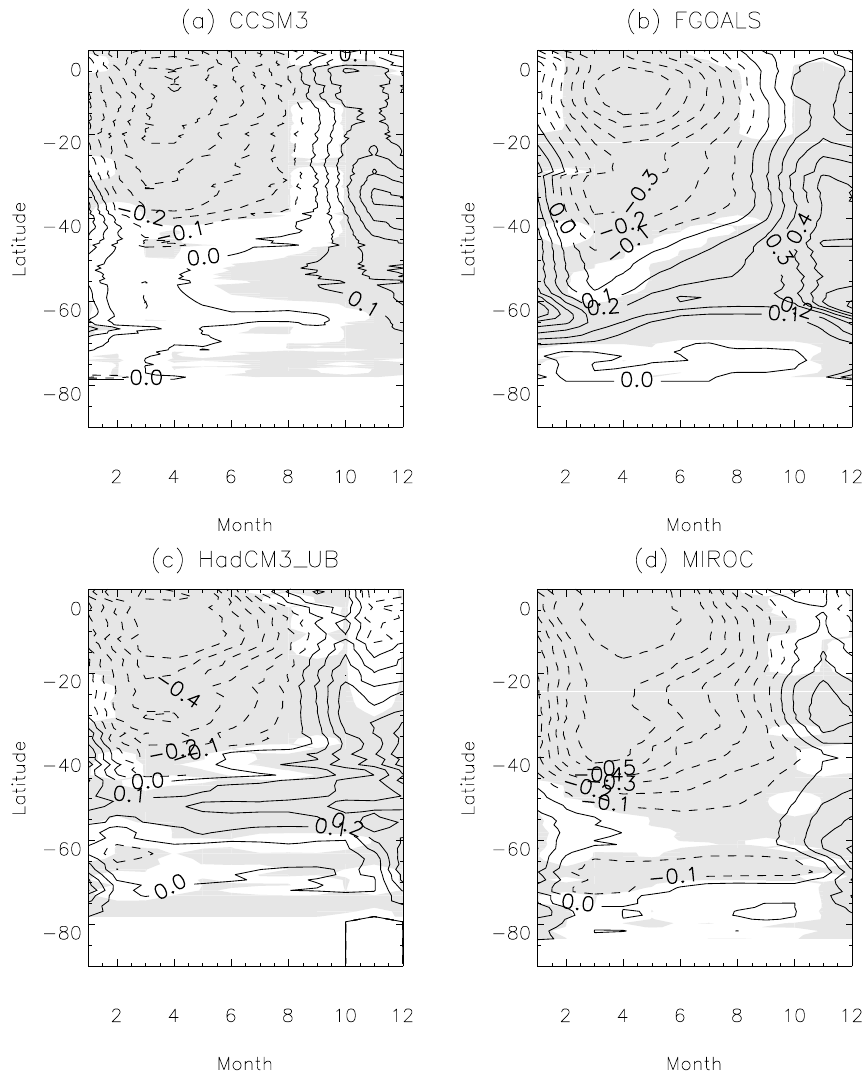
Fig. 7. Zonal mean difference in SST (0 ◦ S–90 ◦ S) between the PMIP2 Mid-Holocene and control runs for (a) CCSM3, (b) FGOALS, (c) HadCM3 UB, and (d) MIROC for each calendar month. Refer to Table 1 for more details on each model. Solid (dashed) lines indicate positive (negative) changes and statistically significant changes ( p ≤ 0.05) are shaded